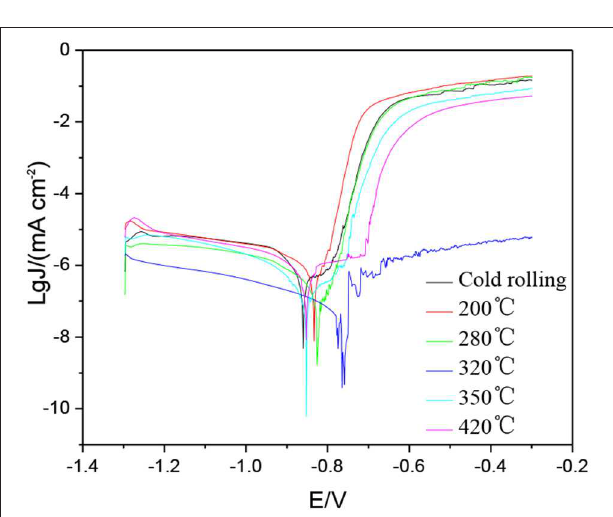
FIGURE 4 | Polarization curves of the Sc-containing alloy annealed at different